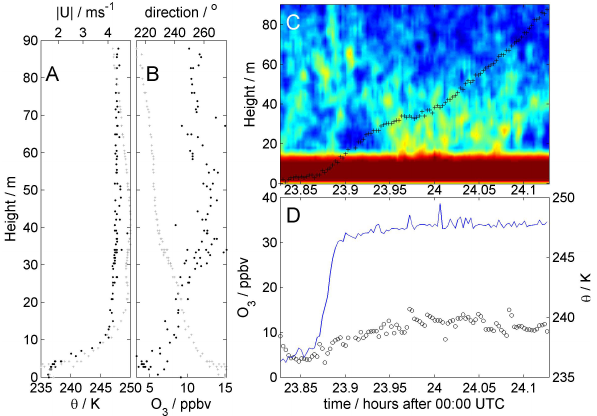
Fig. 7. As for Fig. 3 but now for the night-time flight spanning 2/3 September 2007. Please note the difference in scales.